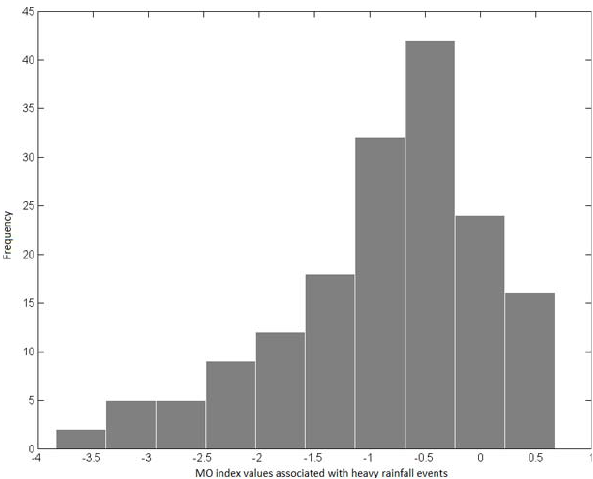
Fig. 3. Daily Mediterranean Oscillation Index values associated with heavy rainfall events.